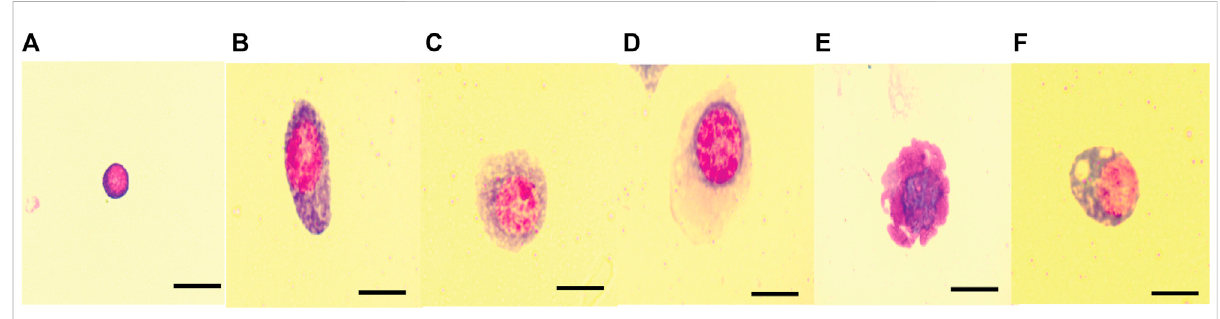
FIGURE 4 Hemocyte types of B. dorsalis and C. cosyra . (A) Prohemocyte, (B) plasmatocyte, (C) granulocyte, (D) oenocyte, (E) spherulocyte, (F) adipohemocyte (only in B. dorsalis ). (Prohemocyte, plasmatocyte and adipocyte images were taken from B. dorsalis larvae microscopic slides; Granulocyte, oenocyte and spherulocyte images were taken from C. cosyra larvae microscopic slides. Scale bars = 10 μ m.